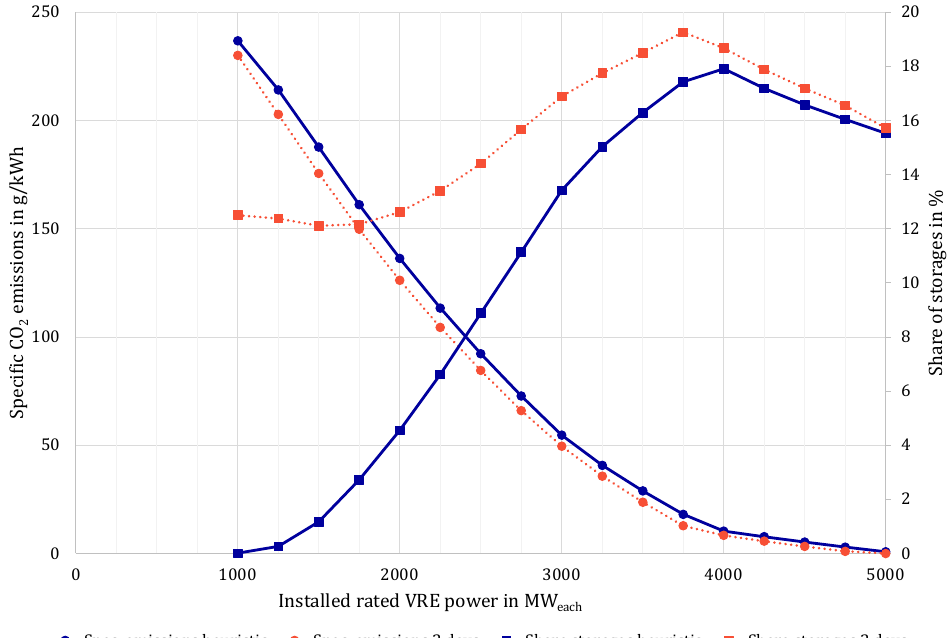
Figure 6. Specific CO 2 emissions (circles) and share of storages of supplied demand (squares) for the heuristic approach (solid lines) and a UCO with a 2 days interval (dotted lines).